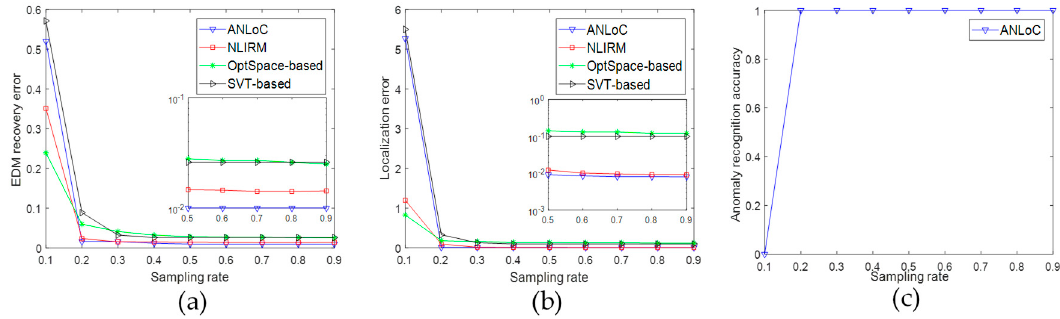
Figure 5. Performance comparison under scenario 3 with only anomaly. ( a ) EDM recovery error; ( b ) localization error; and ( c ) anomaly recognition accuracy.